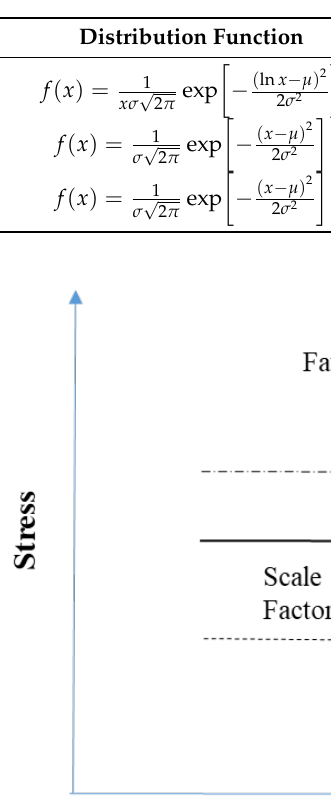
Table 11. Distribution function of fatigue endurance limit of AlSi10Mg.